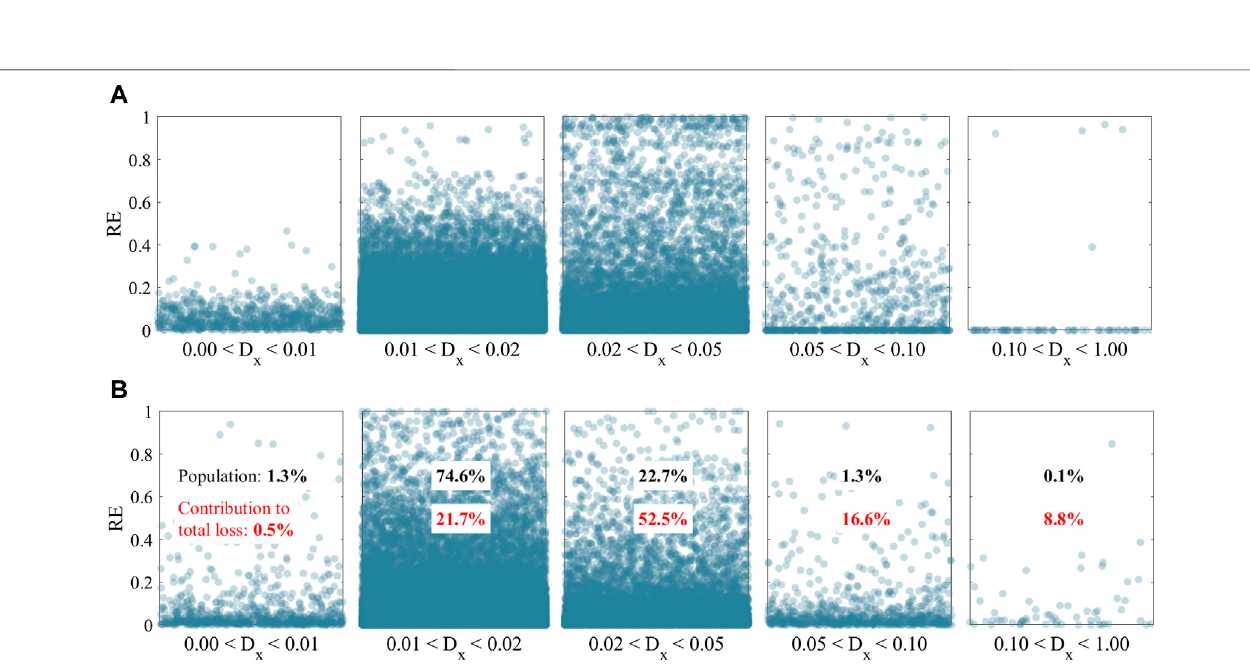
Frontiers in Built Environment |